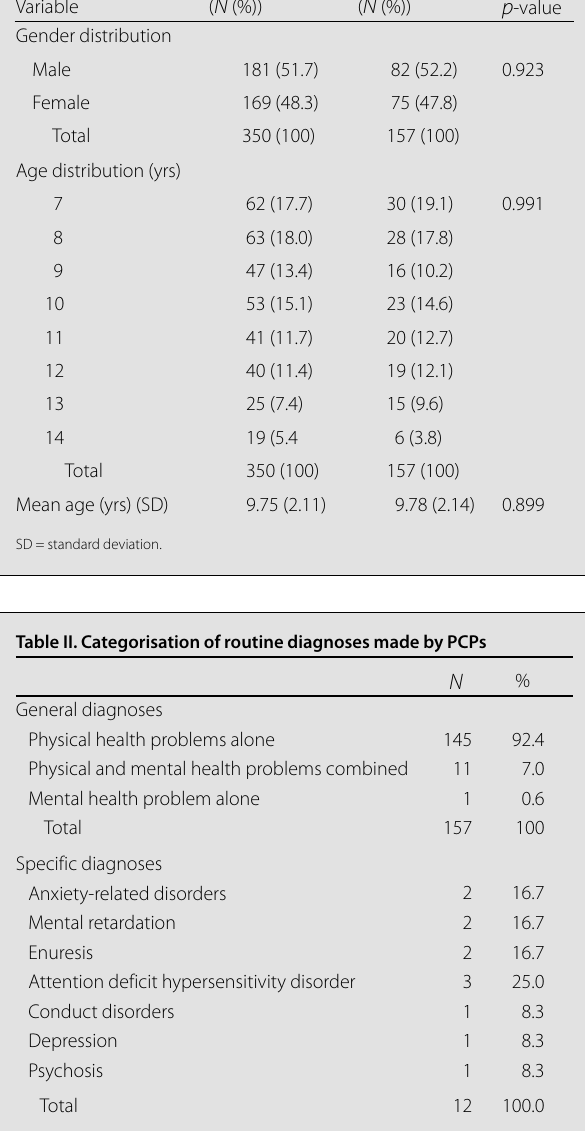
Table I. Mean age and age and gender distribution of children seen in the first and second stages of the study Variable